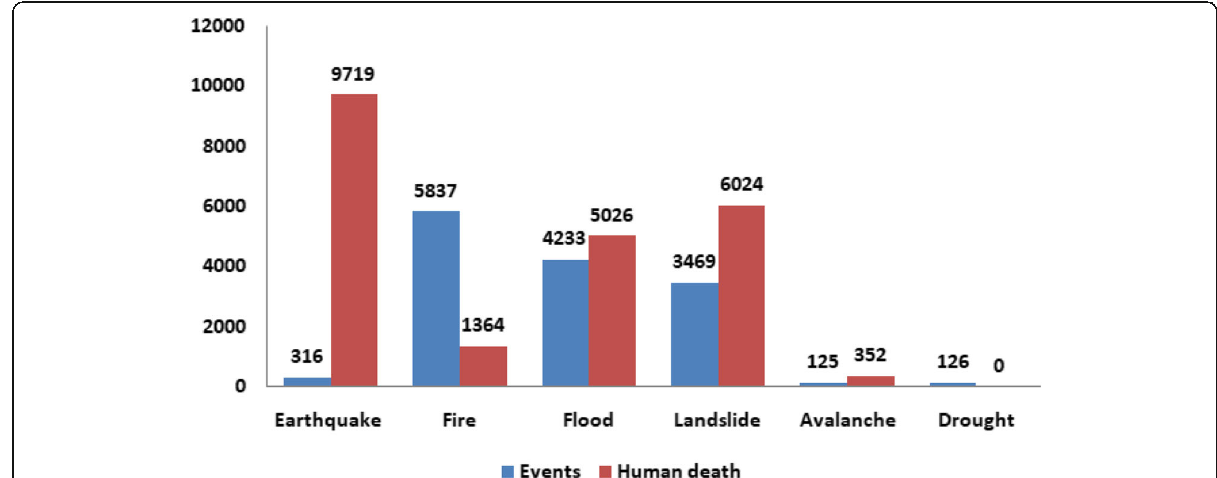
Fig. 3 Disaster in Nepal by the type and loss from 1971 to